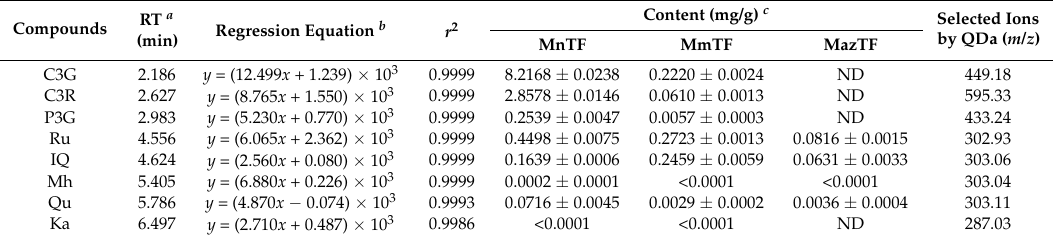
Table 1. Information of chromatography and MS of M. nigra , M. mongolica and M. alba ‘Zhenzhubai’. Compounds Molecules 2018 , 23 , 4